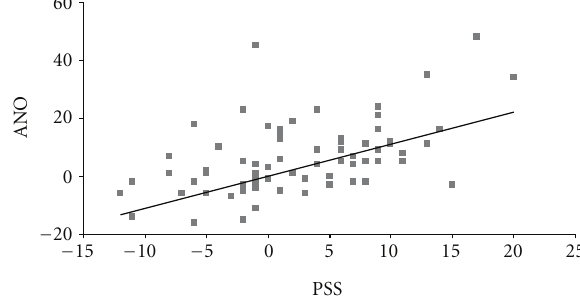
Figure 2: Relationship between anosognosia for dementia and an- osognosia for perceived stress in normal elderly, individuals with Mild Cognitive Impairment, and Alzheimer’s disease patients. This graph represents the lack of association between the scores on an- osognosia for dementia (ANO) and on anosognosia for perceived stress (PSS) in all the subjects. PSS is calculated as a di ff erence score on the PSS-10 as reported by the participants themselves versus the PSS-10 as reported by their